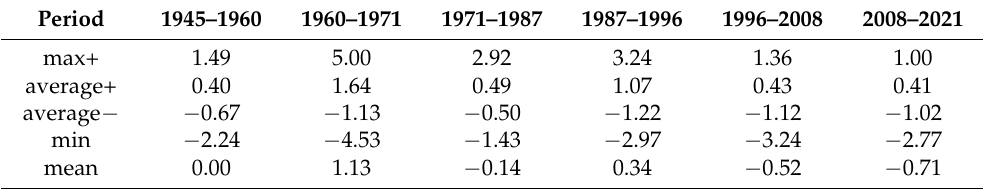
Table 4. Multitemporal shoreline change rate EPR (m/yr) in the Prokopos Lagoon.